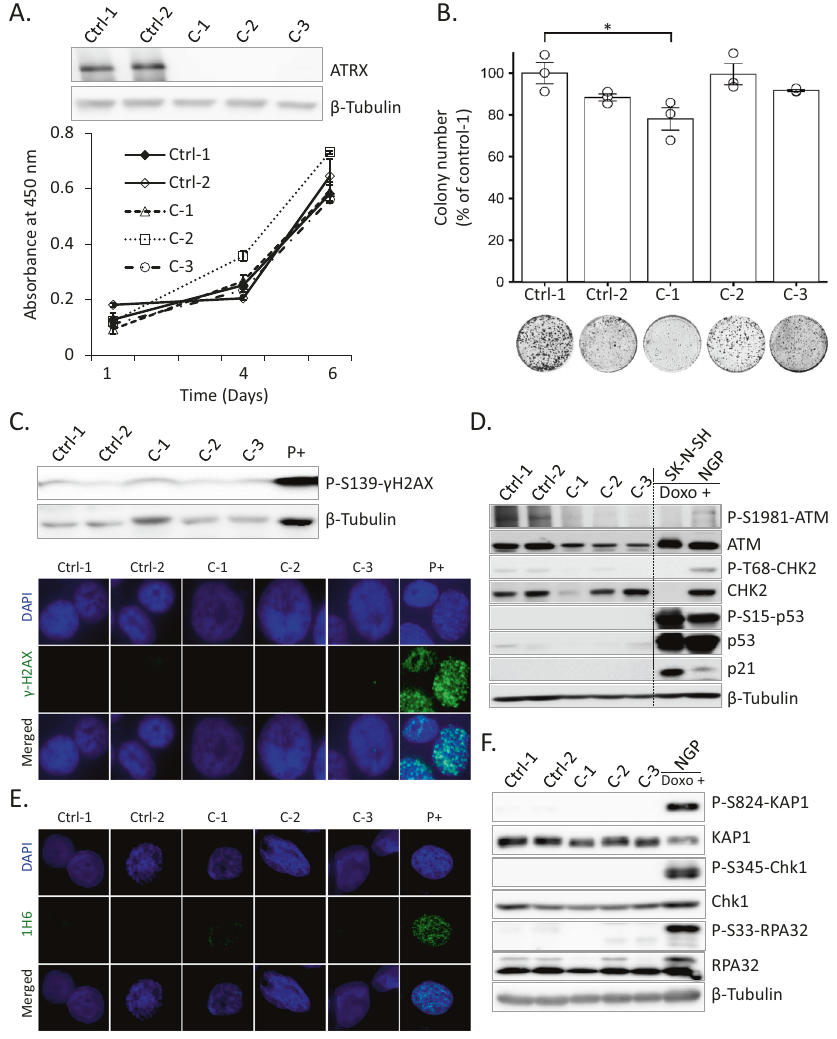
Fig. 4 ATRX de fi ciency-related DDRs and RS were not induced in TP53 -truncated (C terminus) SK-N-AS cells. A Western blot to con fi rm ATRX ablation in Cas9 control (Ctrl) and ATRX KO (C-1, C-2, and C-3) SK-N-AS cells. Growth curves show that cell viability was unchanged between Ctrl and ATRX KO SK-N-AS cells. Data are expressed as means ± standard deviation (SD), N = 3. B Colony formation assays were performed to assess the proliferative abilities of Ctrl and ATRX KO SK-N-AS cells. Lower panel, representative images for clonogenic formation. Error bars represent SD from three technical replicates. * p < 0.05; A one-way ANOVA with Dunnett ’ s and Tukey ’ s test were used for statistical analyses. C Immunoblot and IF analyses of γ H2AX in ATRX -intact (Ctrl) and ATRX KO SK-N-AS cells with a positive control (parental SK-N-AS cells treated with doxorubicin, 0.5 μ g/mL for 24 h). D Immunoblots for the expression of p53-ATM checkpoint proteins in cell lysates prepared from Ctrl and ATRX KO SK-N-AS cells. Doxorubicin (0.5 μ g/mL)-treated two NB cell lines (SK-N-SH and NGP) were used as a positive control. E